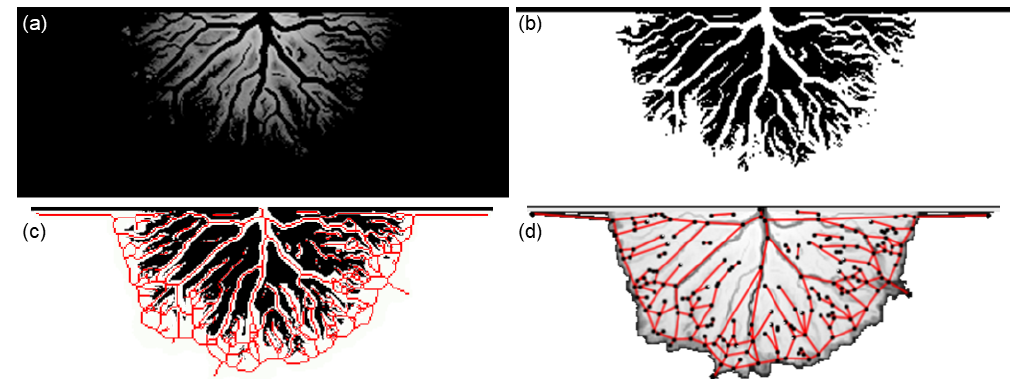
Figure 3. Exemplary overview of workflow to extract the hydrological graph from the imaged delta simulation. (a) Bed elevation, (b) bi- narization of bed elevation to differentiate between channels and non-channels, (c) skeleton (in red) of the channels overlaid on the binary image (b) , and (d) graph of the channel network derived from the skeleton in (c) with edges in red and nodes in black overlaid on the delta